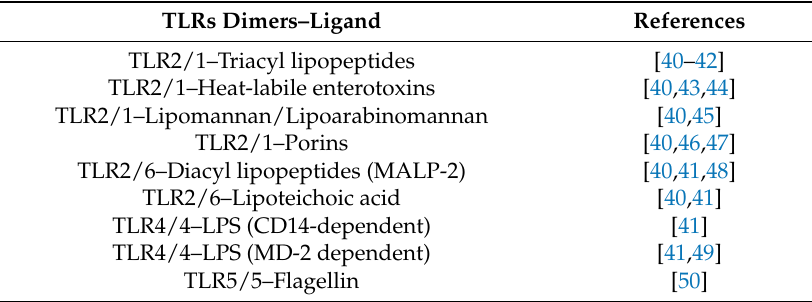
Table 1. Bacterial ligands of TLR2, TLR4, and